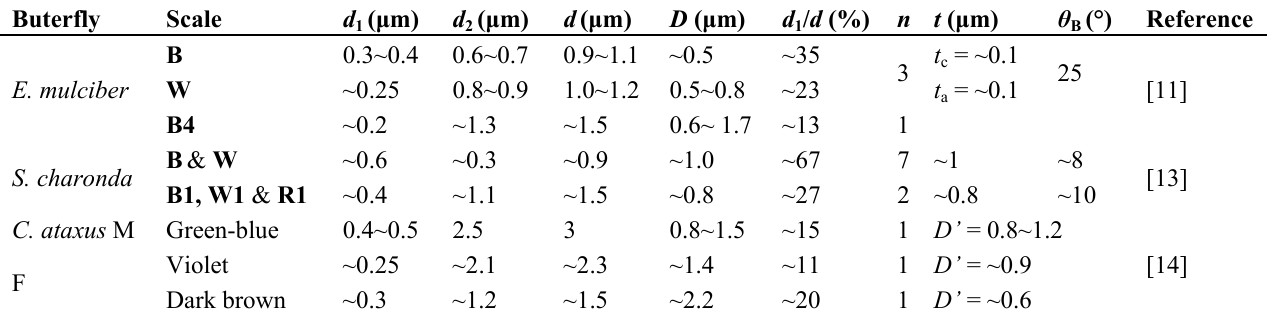
Table 1. Diffraction grating of the wing scales in